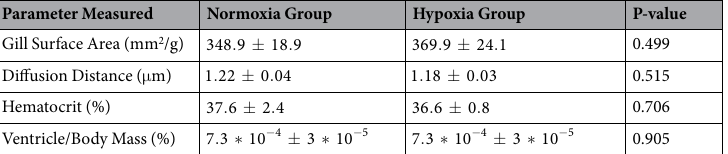
Table 2. Gill surface area standardized to body mass, diffusion distance, hematocrit, and ventricle weight of S . ocellatus subjected to 3 weeks of normoxia or hypoxia. No difference was observed. All data are means ±